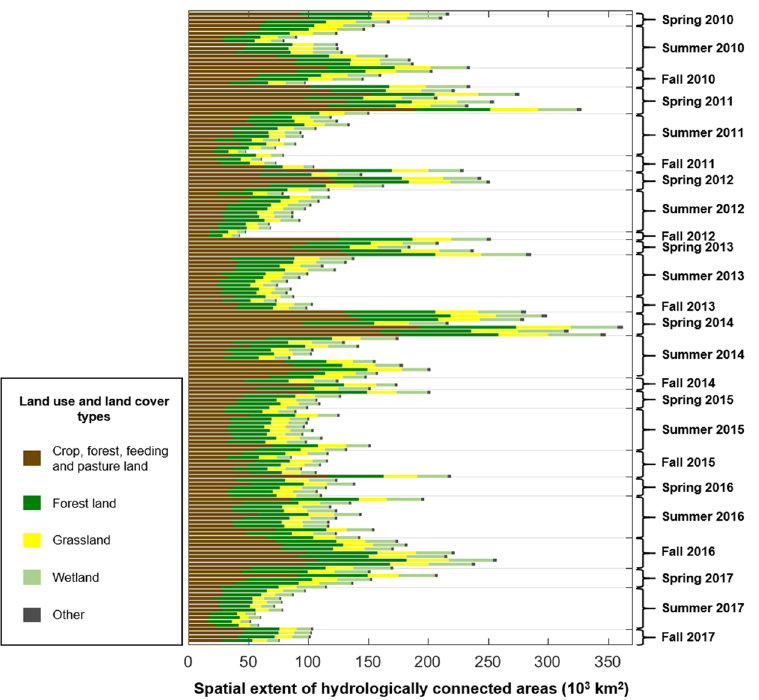
Figure 5. Land use and land cover controls on connectivity. Distribution of hydrologically connected areas across the main land use and land cover types present in the Lake Winnipeg Watershed. Each horizontal bar is associated with a different, weekly map during the 2010–2017 period. The plots were created using MATLAB (version R2016a,